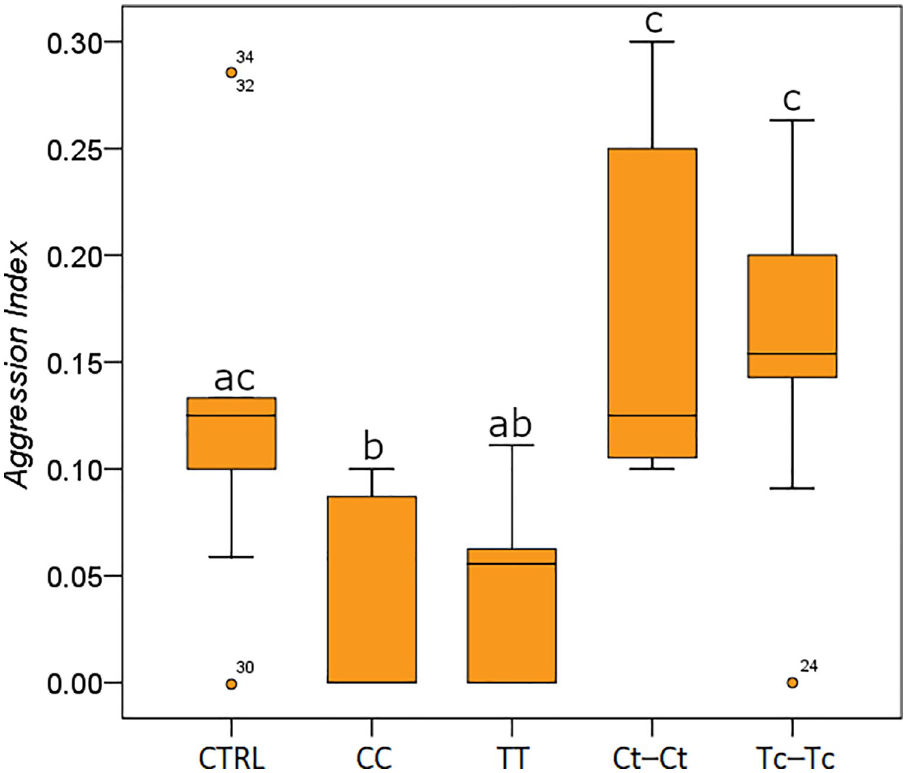
Fig 4. Aggression index. Aggression index between heterocolonial M . scabrinodis workers treated with different compounds or pure air (CTRL: non-treated; CC: carvacrol vs . carvacrol; TT: thymol vs . thymol; Ct-Ct: 3:1 (v/v) carvacrol/thymol vs . 3:1 (v/v) carvacrol/thymol, and Tc-Tc 1:3 (v/v) carvacrol/thymol vs . 1:3 (v/v) carvacrol/thymol). Data are expressed as number of aggressive behaviours on the total number of interaction (see methods for details). Boxplots show median, quartile, maximum and minimum values; different letters indicate significant differences (Tukey’s HSD post hoc, p < 0.05; S4 Table).